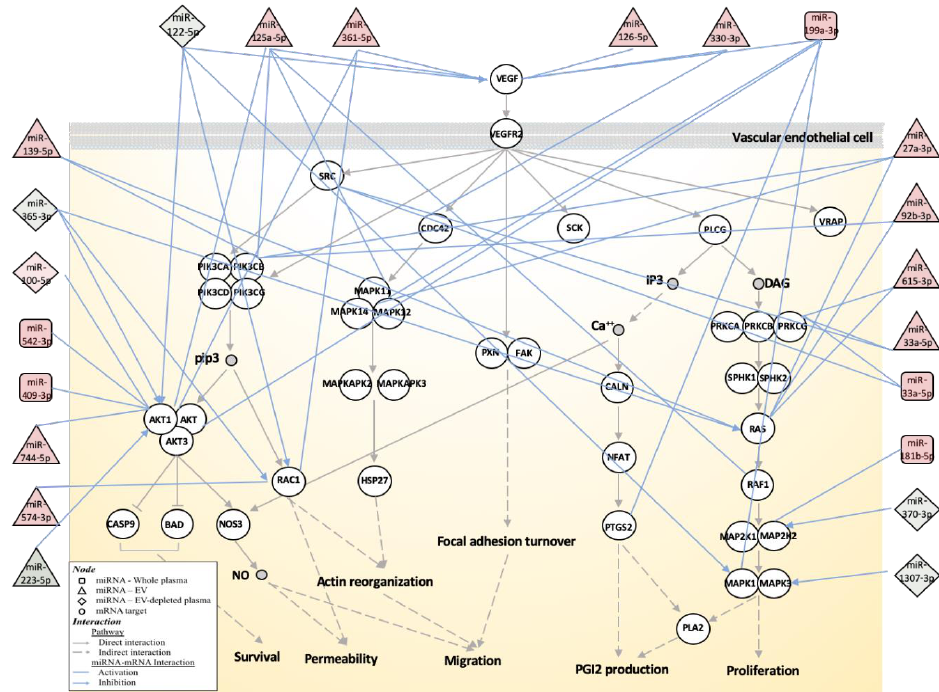
Figure 3. Schematic diagram of mRNA-miRNA interactions associated with the vascular endothelial growth factor (VEGF) signaling pathway. The network is built based on the VEGF signaling pathway map (hsa04370) from the Kyoto Encyclopedia of Genes and Genomes (KEGG), identified by enrichment analysis of miRNA targets. The genes are represented by circles and miRNAs are by squares (whole plasma), triangles (EV) and diamonds (EV-depleted plasma). The identity of genes and miRNAs involved in the process are indicated. The miRNA concentration changes in MMD patients are reflected by either red- (increased concentration in MMD) or green- (decreased concentration in MMD) filled shapes. The miRNA–mRNA interactions are based on validated gene targets from miRTarBase and indicated by light blue